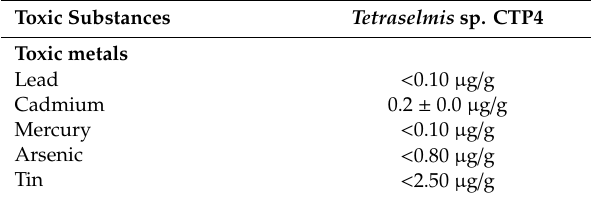
Table 8. Toxicological evaluation of Tetraselmis sp. CTP4 biomass grown semi-continuously in industrial tubular